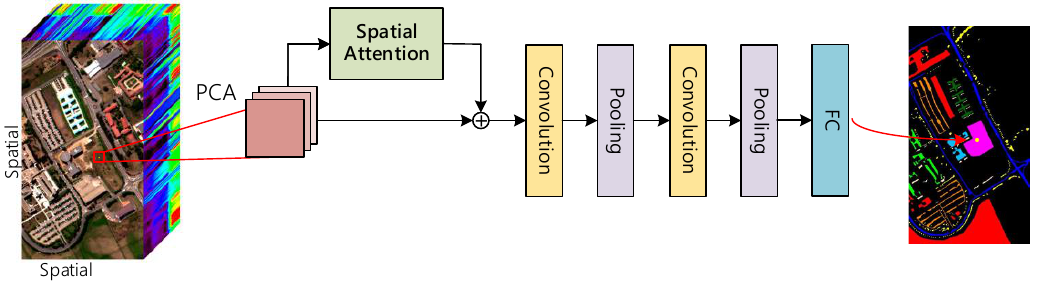
Figure 5. CNN model with attention mechanism for spatial classification. The original HSI is firstly processed by principal component analysis (PCA) for dimensionality reduction. Spatial attention map is calculated from an initial input patch for CNN and superimposed on the patch to the subsequent